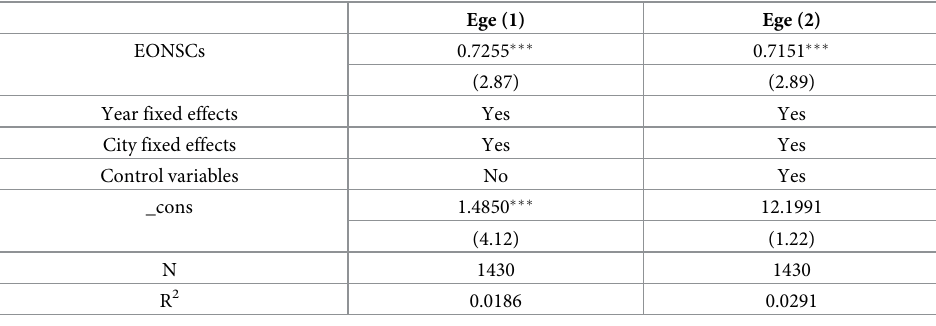
Table 3. Regression results of the benchmark model